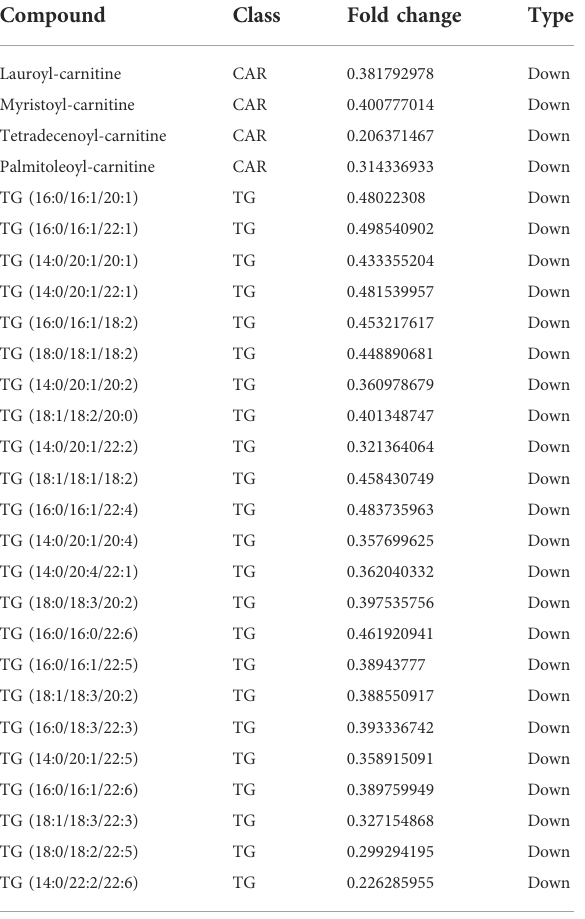
TABLE 3 Differential metabolites in adipocytes knocking down the ACSL1 gene compared with the controls. Compound Class Fold change